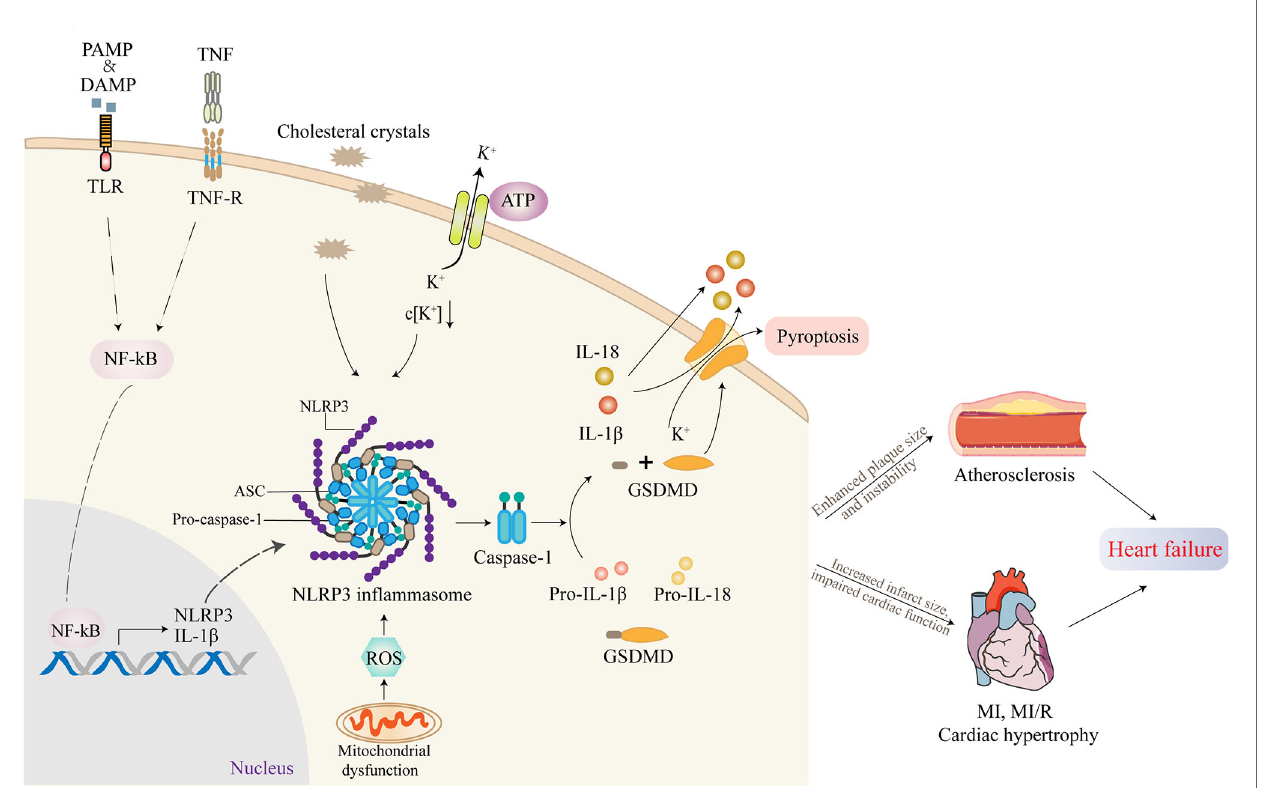
FIGURE 2 | The activation of NLRP3 in fl ammasome and its role in cardiovascular diseases (CVDs). In fl ammasome activation requires two independent steps: priming and triggering. Proin fl ammatory stimuli, such as PAMP, DAMP, or TNF, induce NF- k B signaling through TLR, TNF-R. The transcription factor NF- k B translocates to the nucleus and induces the expression of the IL-1 b precursor pro-IL-1 b and NLRP3. Cholesterol crystals or ox-LDL can be phagocytosed through receptor-mediated phagocytosis, leadingto the formation of cholesterol crystalsin phagolysosomes. Another mechanism of NLRP3 activation involves crystal-induced lysosomal rupture, or ATP-gated P2X7R-mediated decreased intracellular K + concentration can activateNLRP3 protein. Once activated, NLRP3 recruits adapter molecule ASC, which interacts with pro-caspase-1, resulting inthe formation of NLRP3 in fl ammasome. Active NLRP3 in fl ammasome promotes the recruitmentand activation of caspase-1, which isresponsible for the activation of IL-1 b and IL-18 as wellas the cleavage ofGSDMD.The cleaved GSDMDthen forms pores onthe cellmembrane, triggeringpyroptosis. Most studies supportedthat theactivation of NLRP3 in fl ammasome contributed to the development ofatherosclerosis (AS), myocardial infarction (MI), myocardial ischemia/reperfusion (MI/R),and cardiac hypertrophy, which ultimately promoted heart